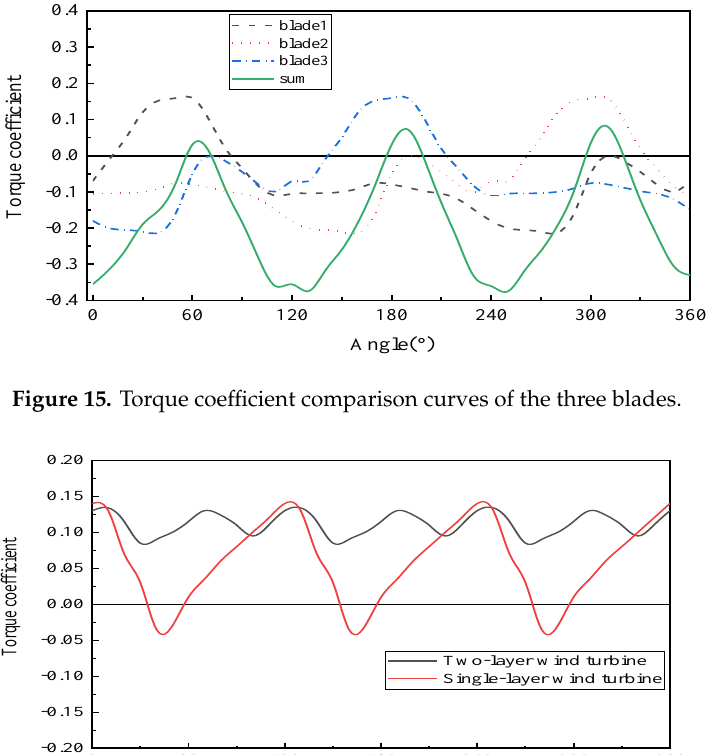
Figure 15. Torque coefficient comparison curves of the three blades.